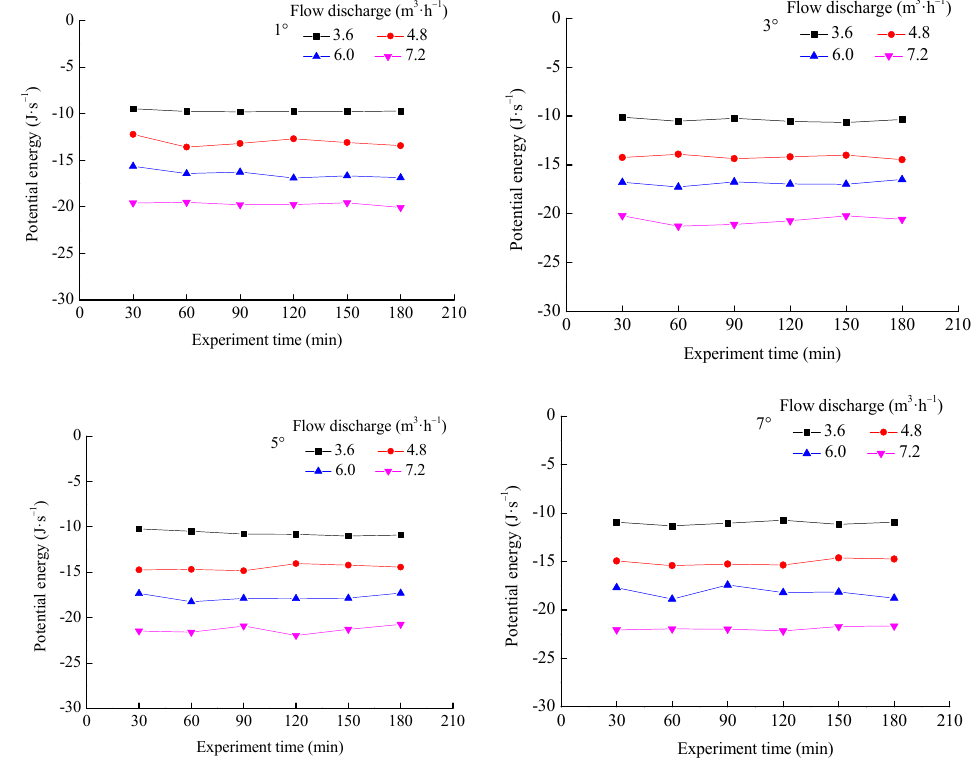
Figure 5. Potential energy variations in the downstream gully bed through the time of the experi ‐ ment.